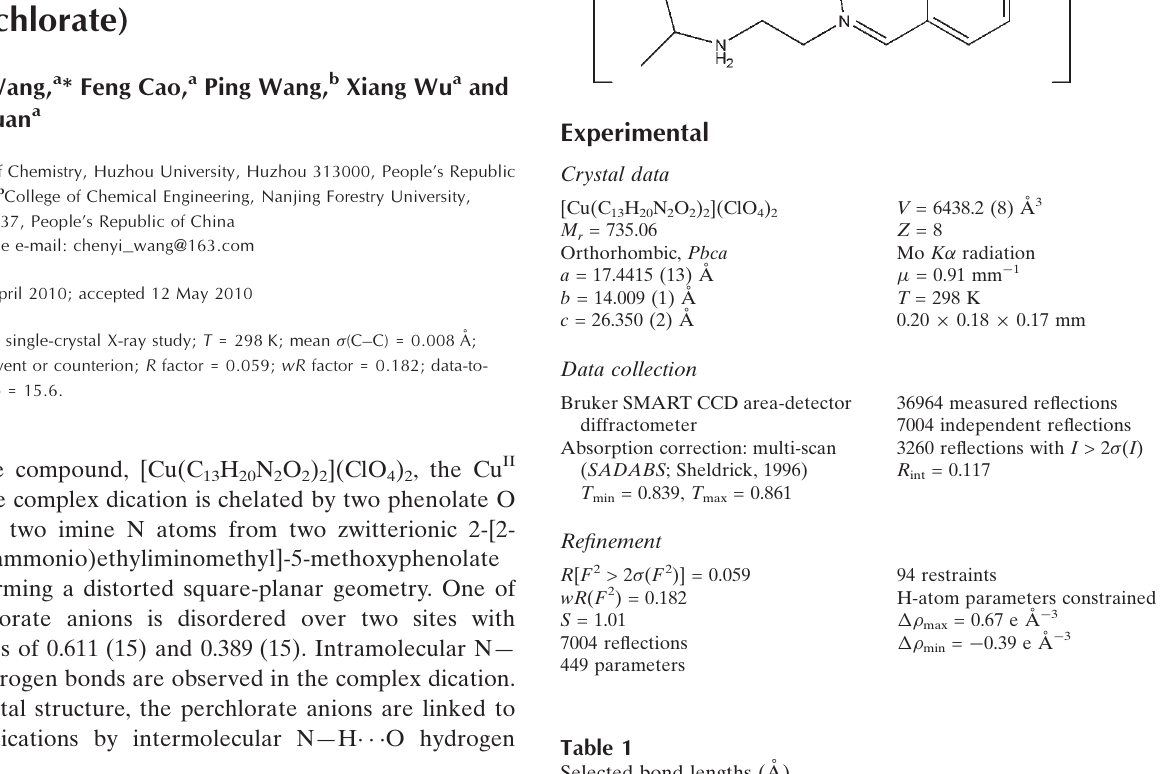
Selected bond lengths (A˚ ).